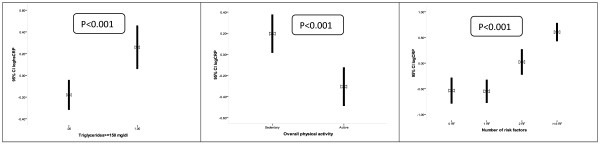
Association between CRP and physical activity, triglycerides and clustering of risk factors of CVD (error bars). hsCRP, high sensitivity C-reactive protein